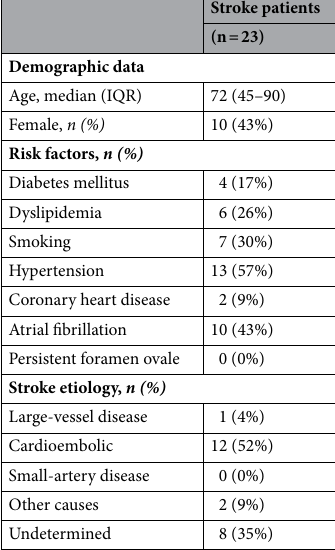
Table 1. Patient clinical characteristics. Clinical characteristics of all 23 patients. Numbers ( n ) and percentage or median and interquartile range ( IQR ) are shown.